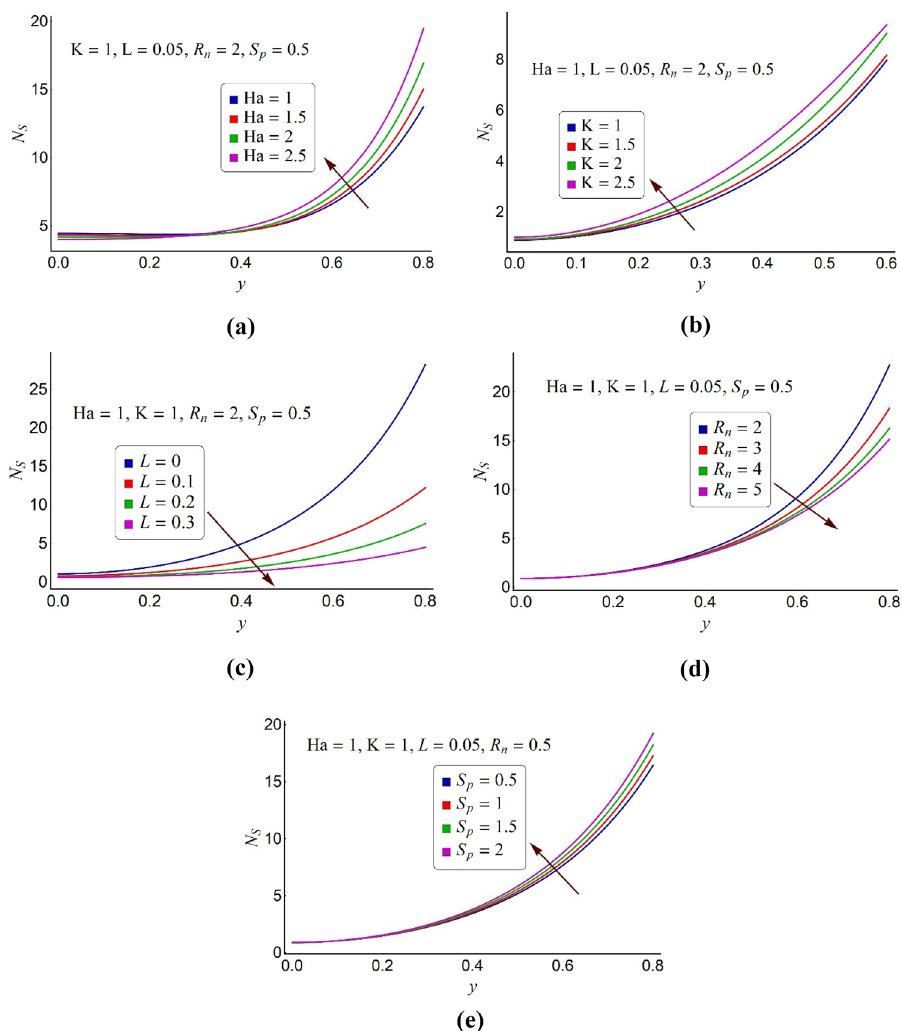
Figure 6. Alterations in the entropy formation number of ternary fluid for various values of ( a ) Hartmann number Ha, ( b ) electroosmotic parameter K, ( c ) momentum slip parameter L , ( d ) thermal radiation number R n , ( e ) ohmic heating parameter S p